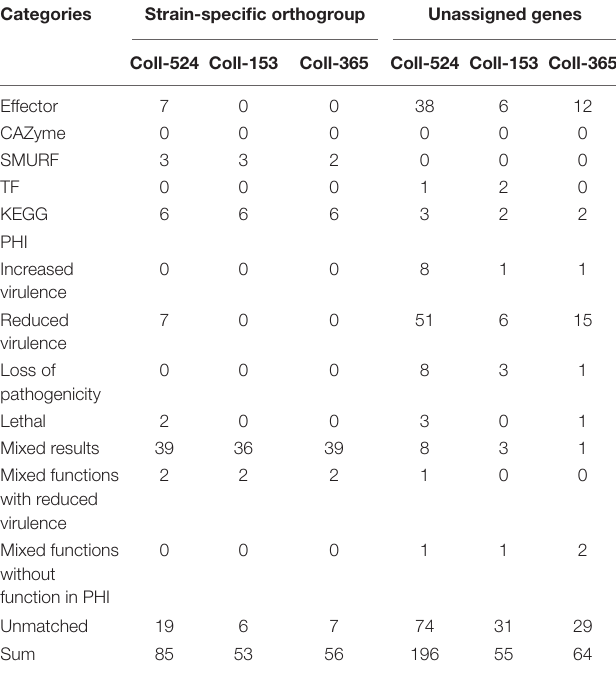
TABLE 4 | Functional category statistics of strain-specific orthogroups and unassigned genes of the three Colletotrichum scovillei genomes.